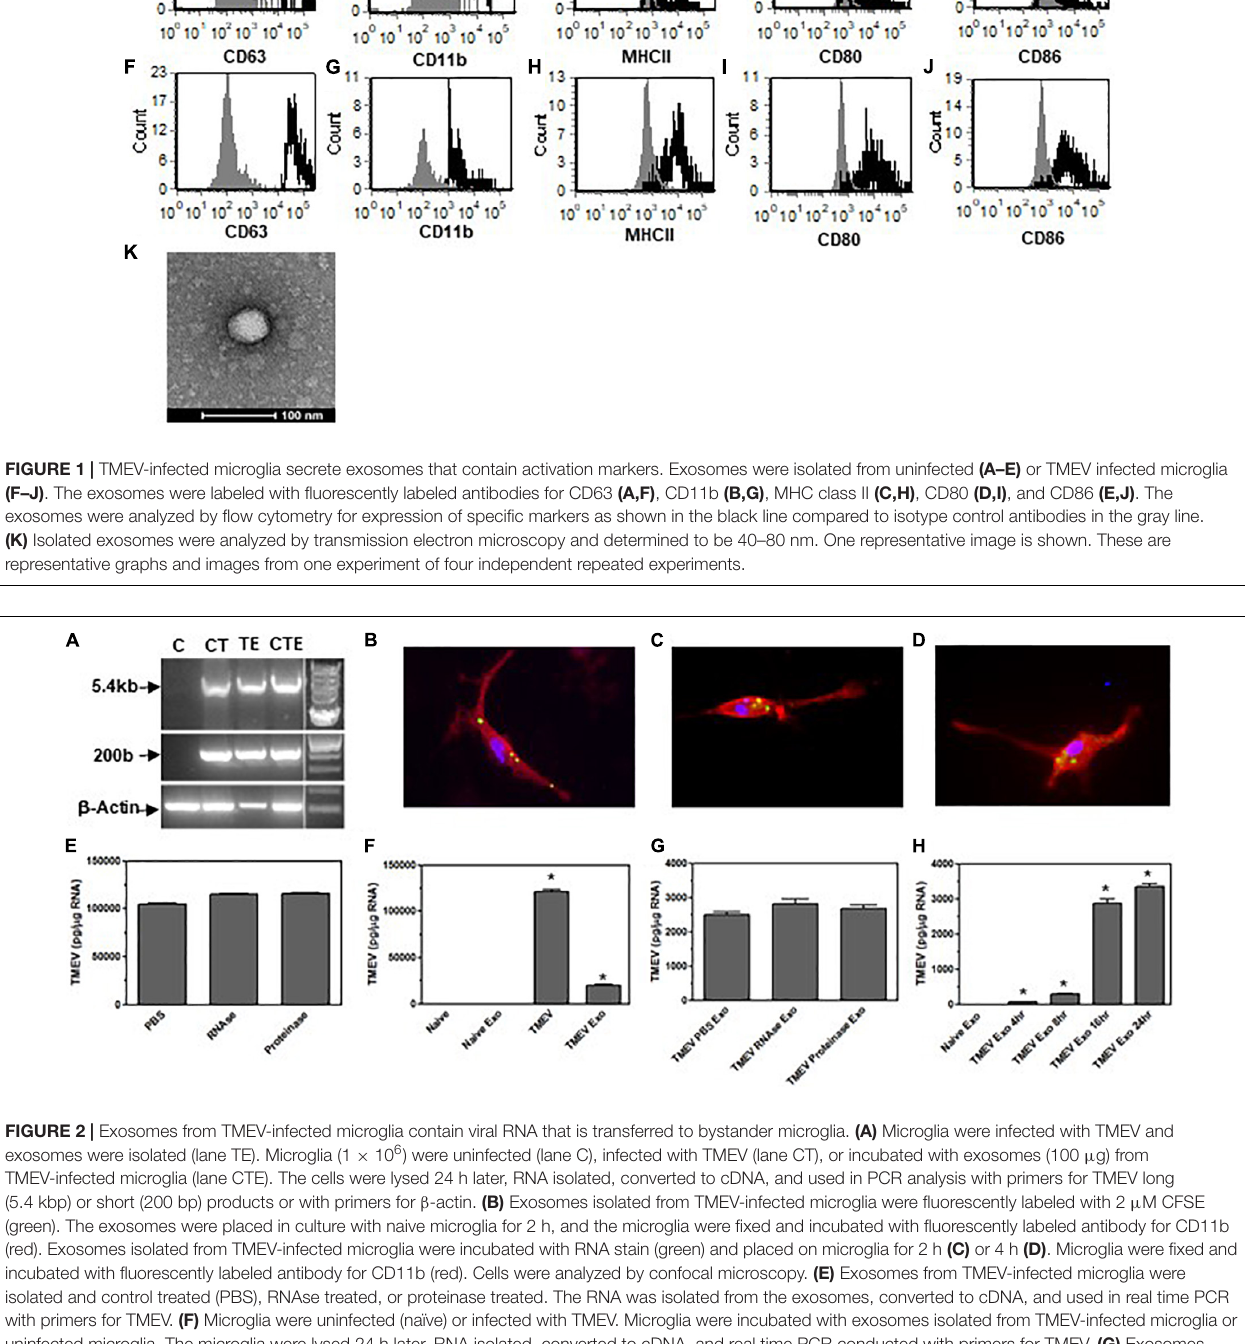
Frontiers in Cell and Developmental Biology |